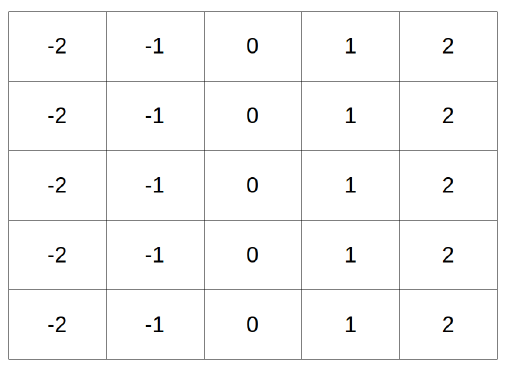
Figure 9. Example of an unnormalized x-coordinate tensor for a 5 × 5 pixels image.